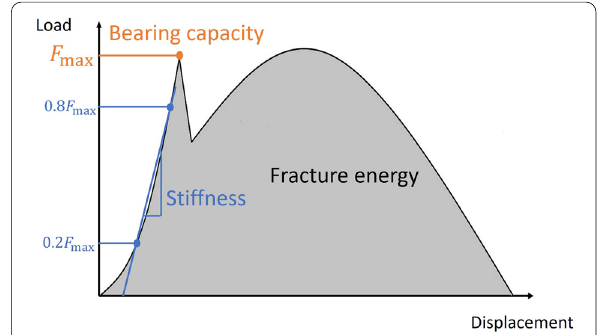
Fig. 5 Definition of three types of mechanical parameters